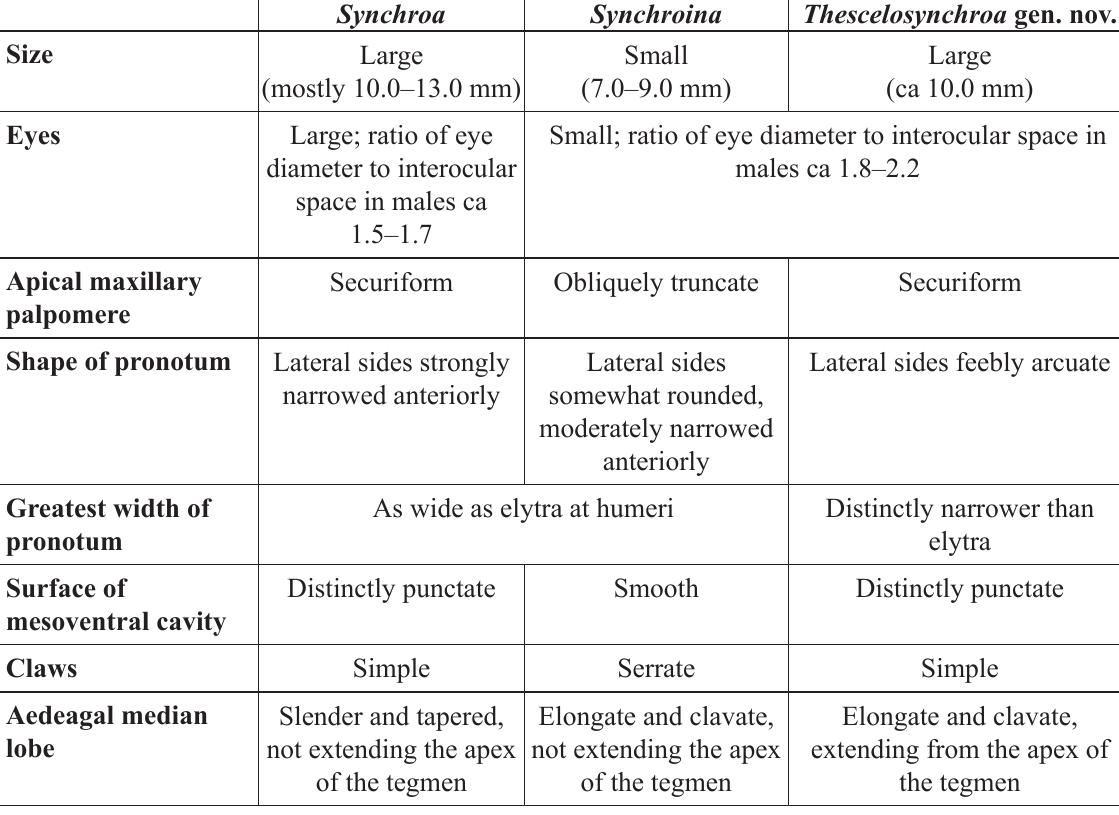
Table 2. Diagnostic characters among Synchroa Newman, 1838, Synchroina Fairmaire, 1898 and Thescelosynchroa gen.